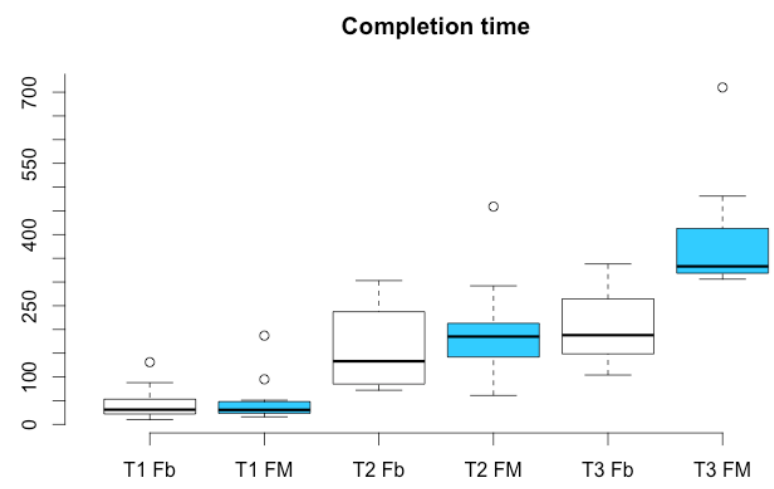
Figure 11. Task completion time in seconds. The white boxes represent the time required for planning the task on Facebook, while light-blue boxes represent the completion time with FaceMashup.